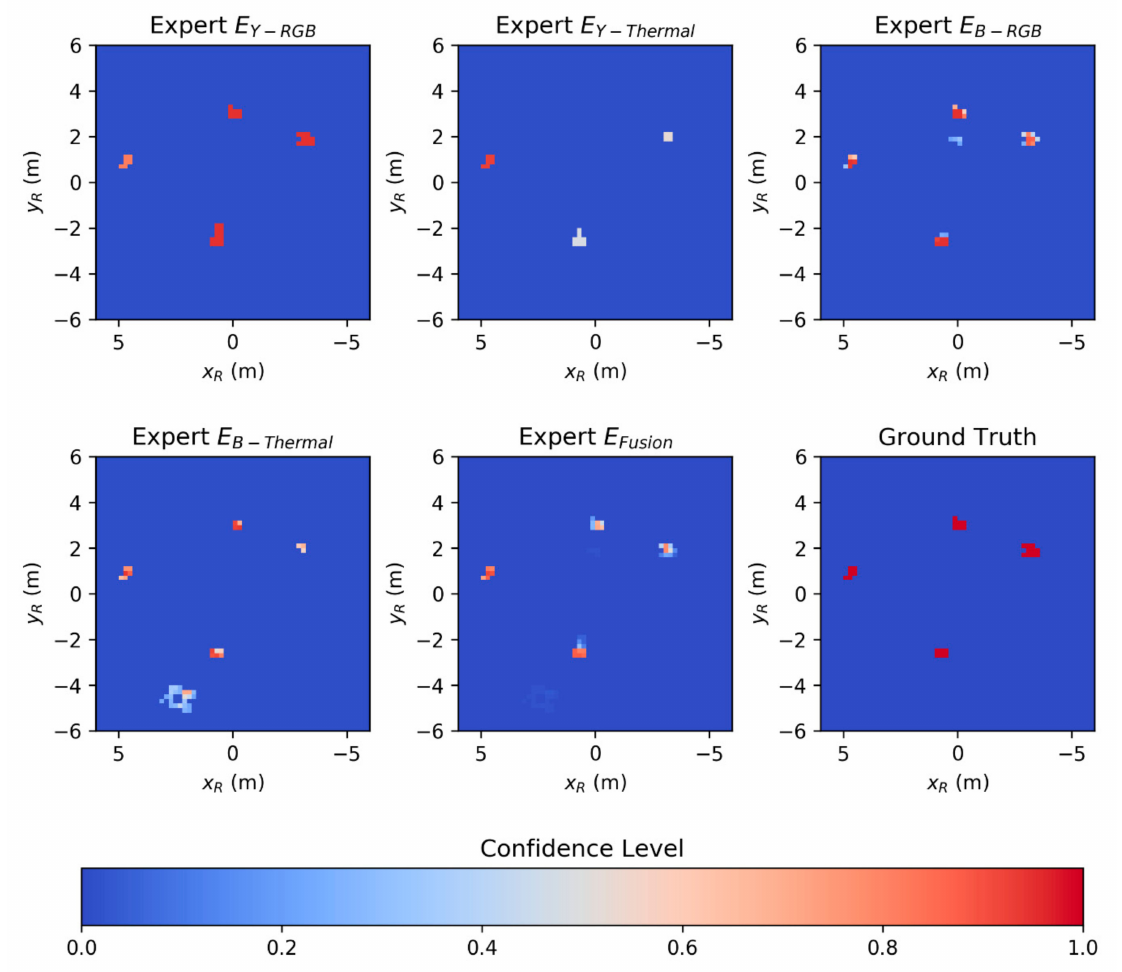
Figure 10. Heatmaps generated by the five di ff erent experts of the workspace monitoring system (WMS) and the ground